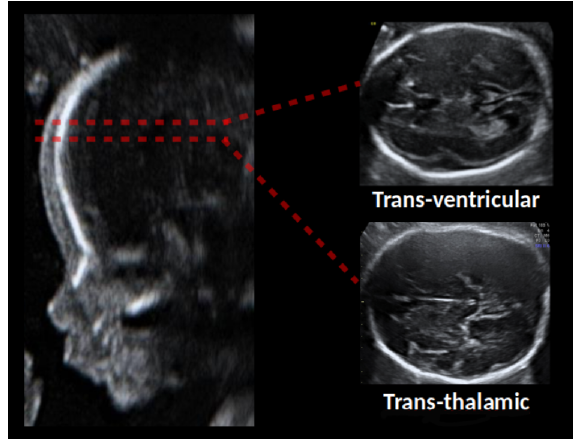
Figure 1. Fetal brain plane images used in this study